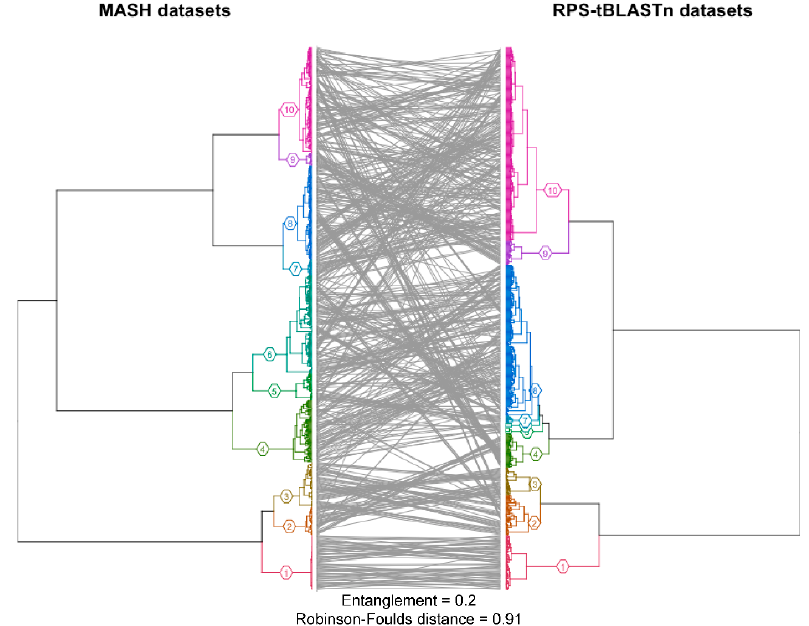
Figure 3. Tanglegram depicting hierarchical clustering performed on the Canberra distance matrices derived from the domain counts matrices of both Mash and RPS-tBLASTn pipelines. Both dendrograms are colored by their cluster id with k = 10. Base R function hclust was used to generate the clustering [18]. Correlation between both matrices was calculated with the Mantel test implemented in the ade4 R package [19]. The entanglement value and plot were generated with the Entanglement and Tanglegram functions implemented in the dendextend package [21]. Robinson–Foulds distance was calculated using the RF.dist function implemented in the Phangorn package [20].